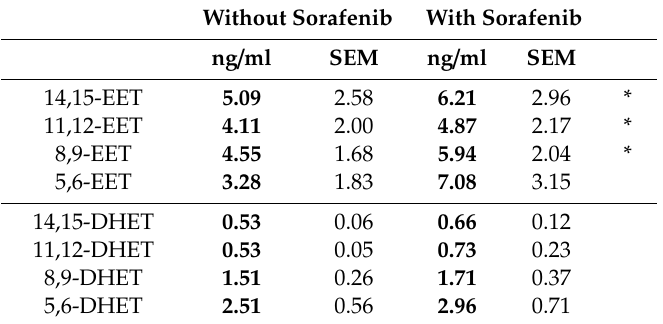
Table 2. Epoxy and corresponding dihydroxy metabolites in blood samples. Without